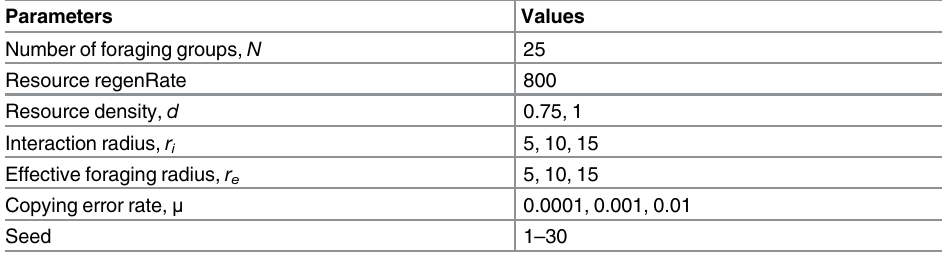
Table 1. Parameter values used in the experimental